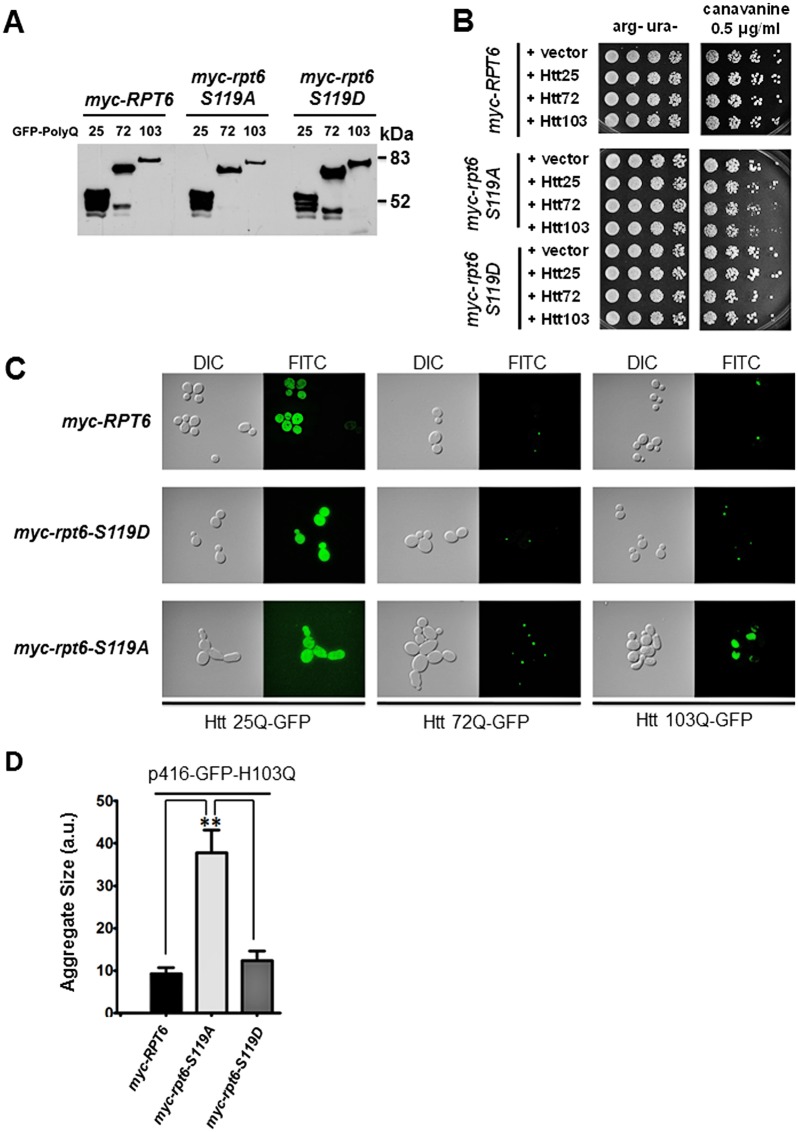
Altered Rpt6 phosphorylation and proteasome function exacerbated Htt polyQ aggregation and proteotoxicity.(A) Representative immunoblot (anti-GFP) of GFP-tagged (Htt) with different polyQ repeats (Htt25Q, Htt72Q and Htt103Q). Expression is similar in all myc-Rpt6 strains. (B) Expression of Htt72Q and Htt103Q increased the sensitivity of myc-rpt6-S119A to canavanine. Strains transformed with URA3 marked vector, Htt25, Htt72 and Htt103 plasmids were plated on canavanine to induce proteotoxic stress. The arg- ura- plates are controls. (C) Representative images of RPT6 mutants transformed with Htt25Q, Htt72Q and Htt103Q constructs. Larger GFP-Htt aggregates are observed in the myc-rpt6-S119A mutant compared to WT and the myc-rpt6-S119D mutant. (D) Quantification of aggregate size (total GFP signal within a cell) is presented for Htt103Q expression. Graphs depict mean aggregate size ± SEM (arbitrary units). **p < 0.01, one way ANOVA. n = 45 to 60 individual GFP-aggregates (cells) measured over 2 independent experiments.